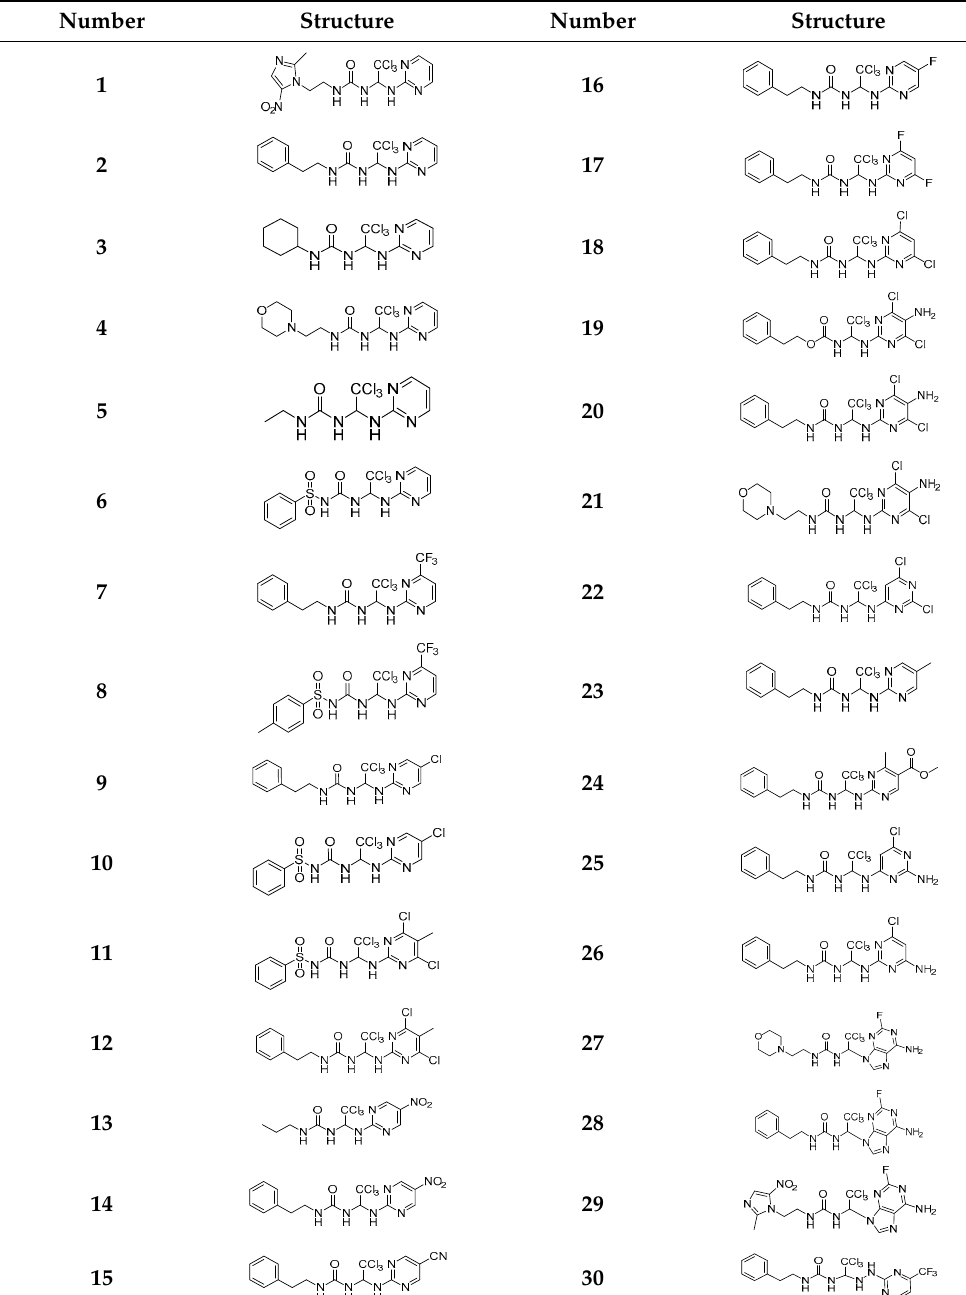
Table 1. Structures of synthesized compounds.